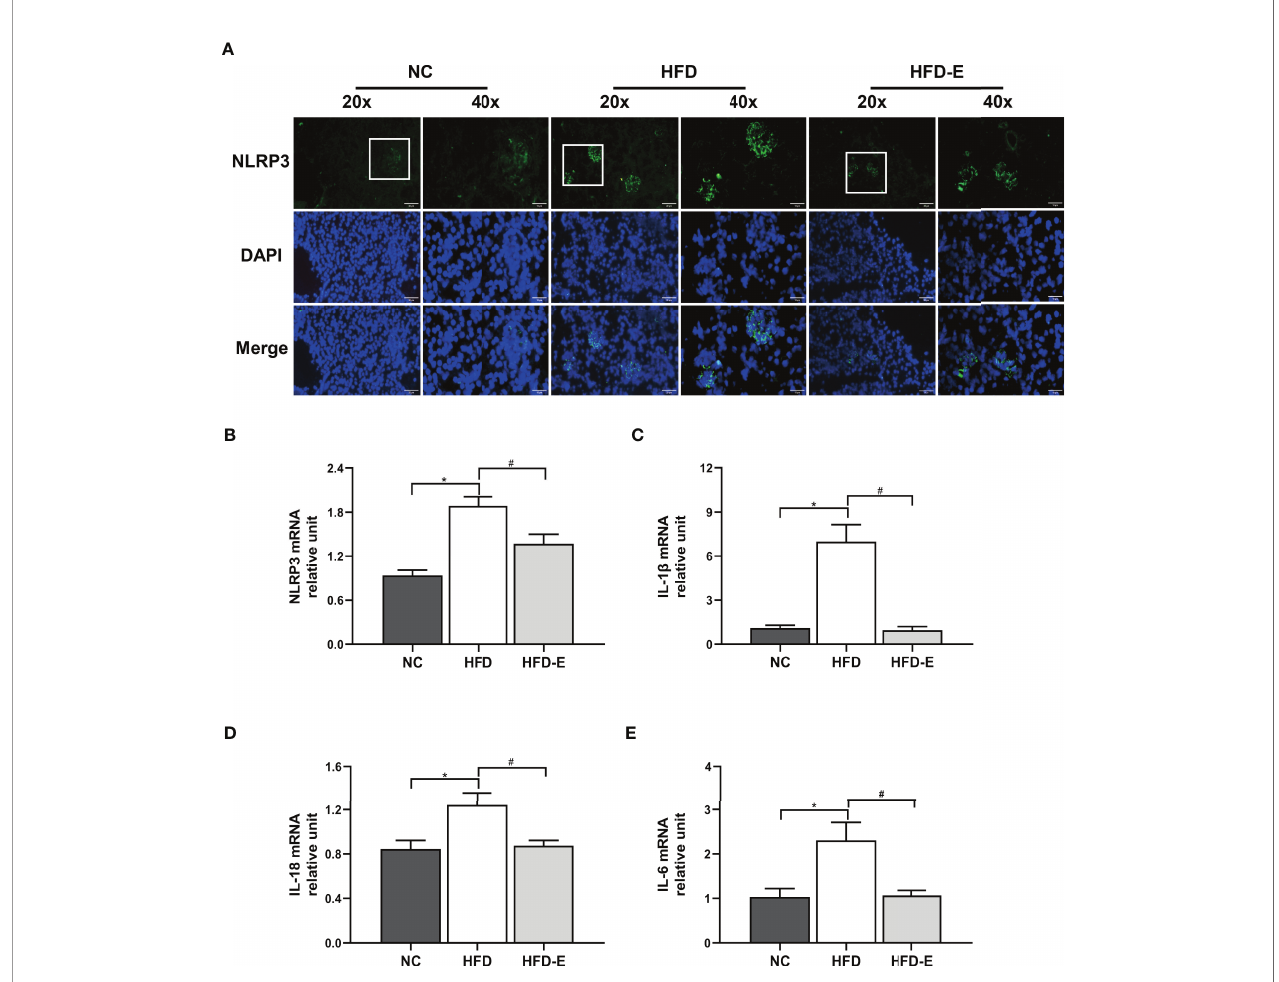
FIGURE 4 | EMPA attenuated the NLRP3 in fl ammasome. (A) Immuno fl uorescence of NLRP3 in fl ammasome. Scale bar = 20 µm and 10 µm. (B – E) mRNA levels of NLRP3, IL-1 b , IL-6, IL-18 (n = 6/group). Data are means ± SEM. *P < 0.05 NC; # P < 0.05 vs.